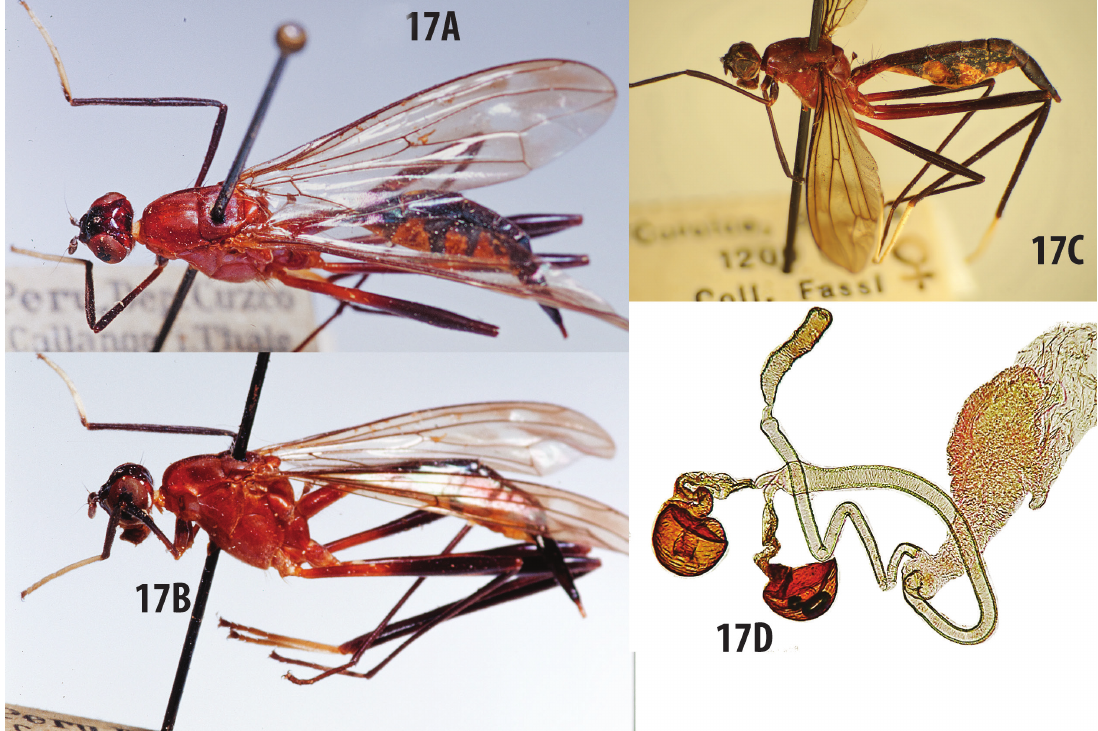
Fig. 17. Mesoconius rufithorax Enderlein, 1922. A–B . Lectotype, ♀, MNBG, Peru. C . ♀, Bolivia. D . Spermathecae and associated structures, lateral view,